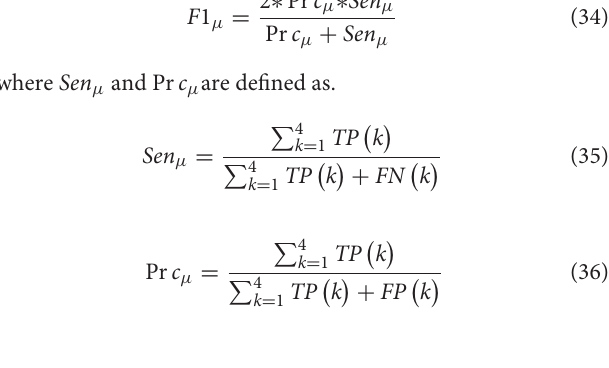
TABLE 8 | Comparison of different pooling methods.